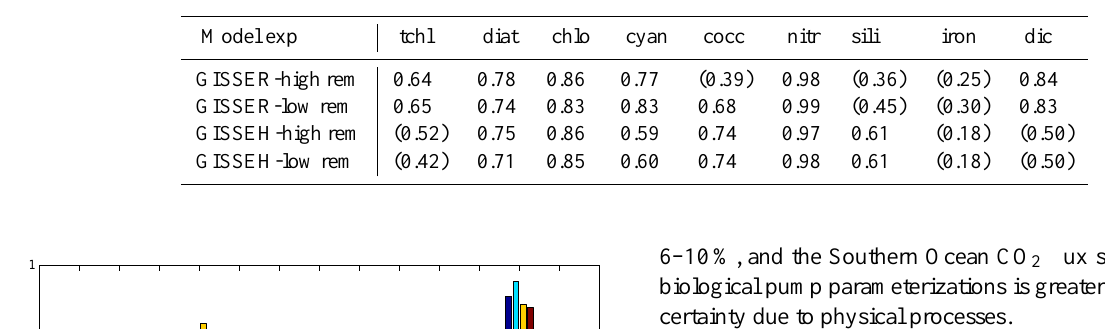
Table 1. Correlation coefficients of the spatial patterns between model experiments and observations. Values in parentheses are below the 5% confidence level.